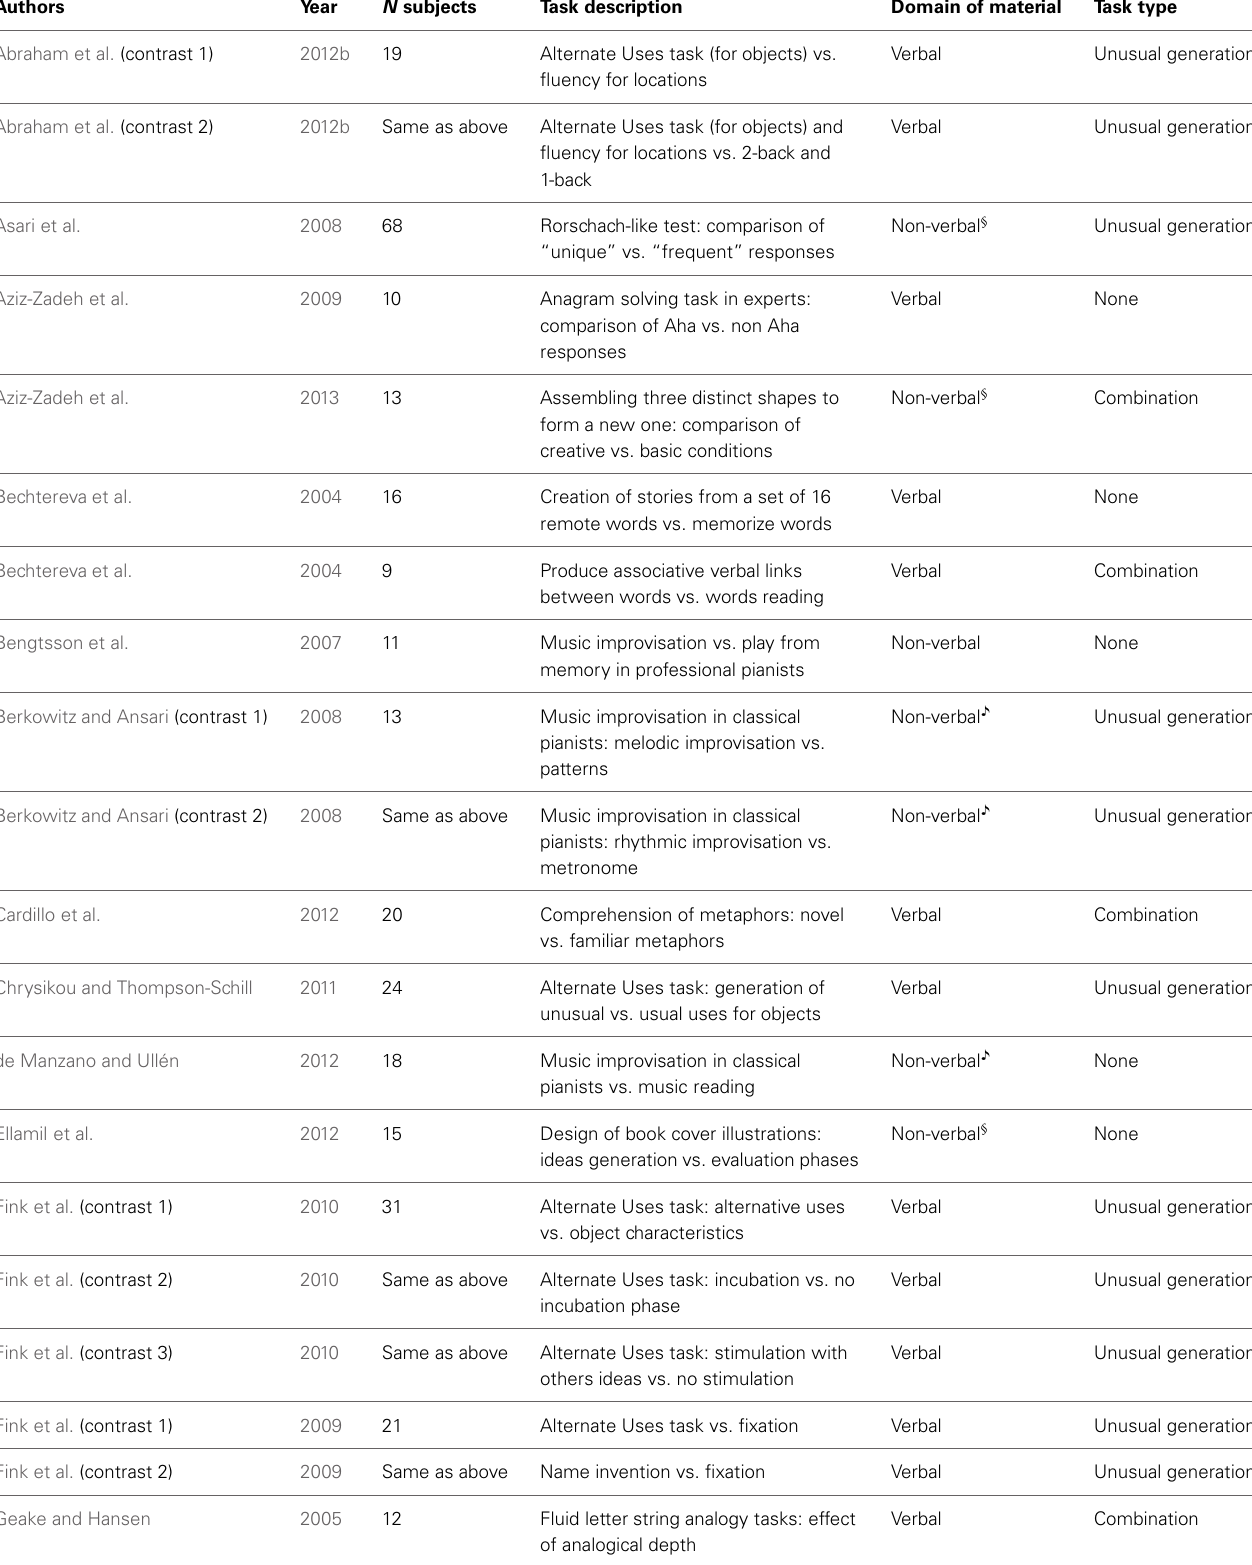
Table 1 | List of the included studies with task description and